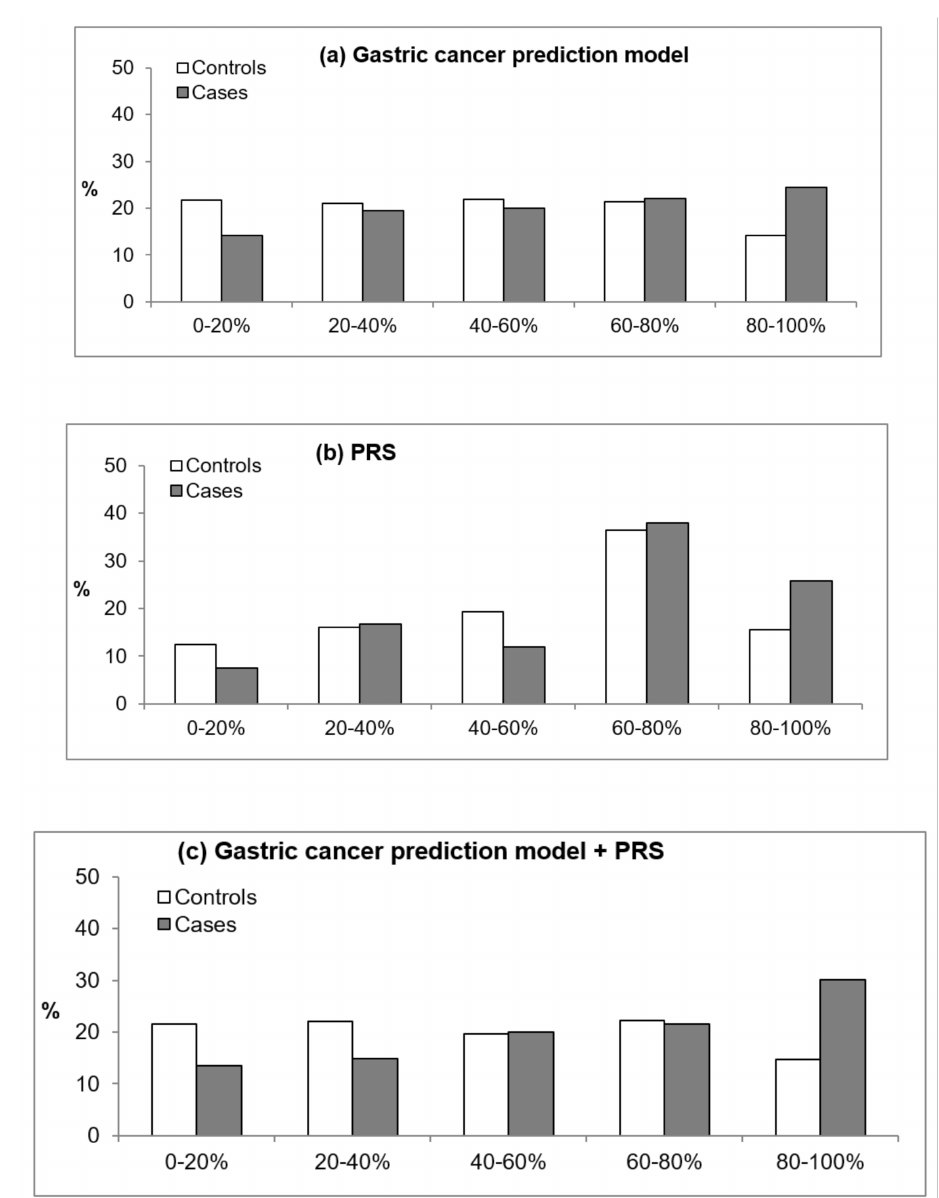
Figure 2. Percentages of patients and controls by quintile estimates according to the estimated score using the gastric cancer prediction model (GCS), unweighted polygenic score (PRS), and PRS-GCS for subjects with Helicobacter pylori infection. ( a ) The gastric cancer prediction model, ( b ) the PRS, and ( c ) the gastric cancer prediction model +